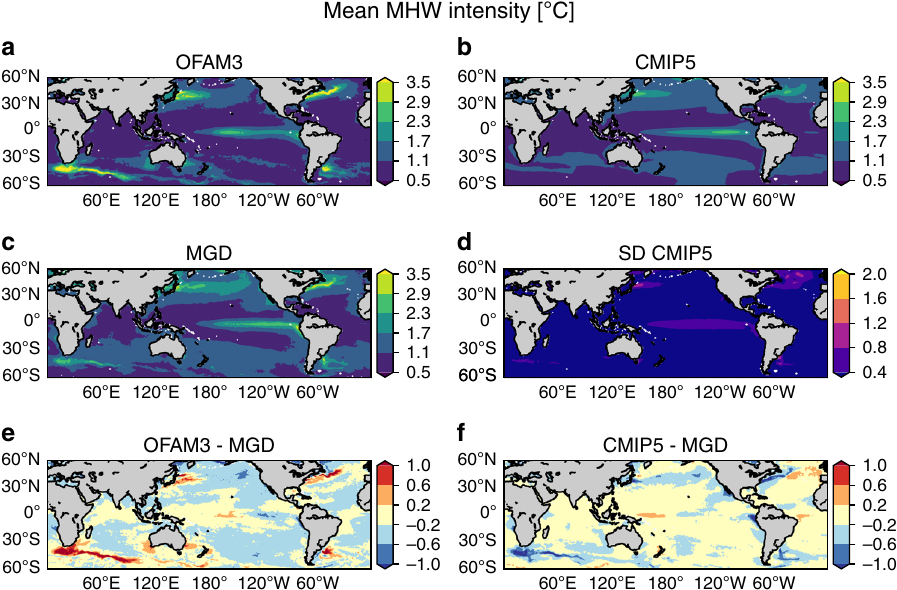
Fig. 2 Historical mean marine heatwave intensity. Spatial distributions of mean marine heatwave (MHW) intensity averaged over 1982 – 2018 based on a a high-resolution ocean model (OFAM3), b the multi-model mean product of 23 global climate models (CMIP5) and c observations (MGD). d Inter- model spread of the CMIP5 models, as determined by standard deviations. Biases in e OFAM3 and f the CMIP5 multi-model mean product, as determined by their difference from (Fig. 2e, f). OFAM3 simulates >1 °C more intense MHWs in